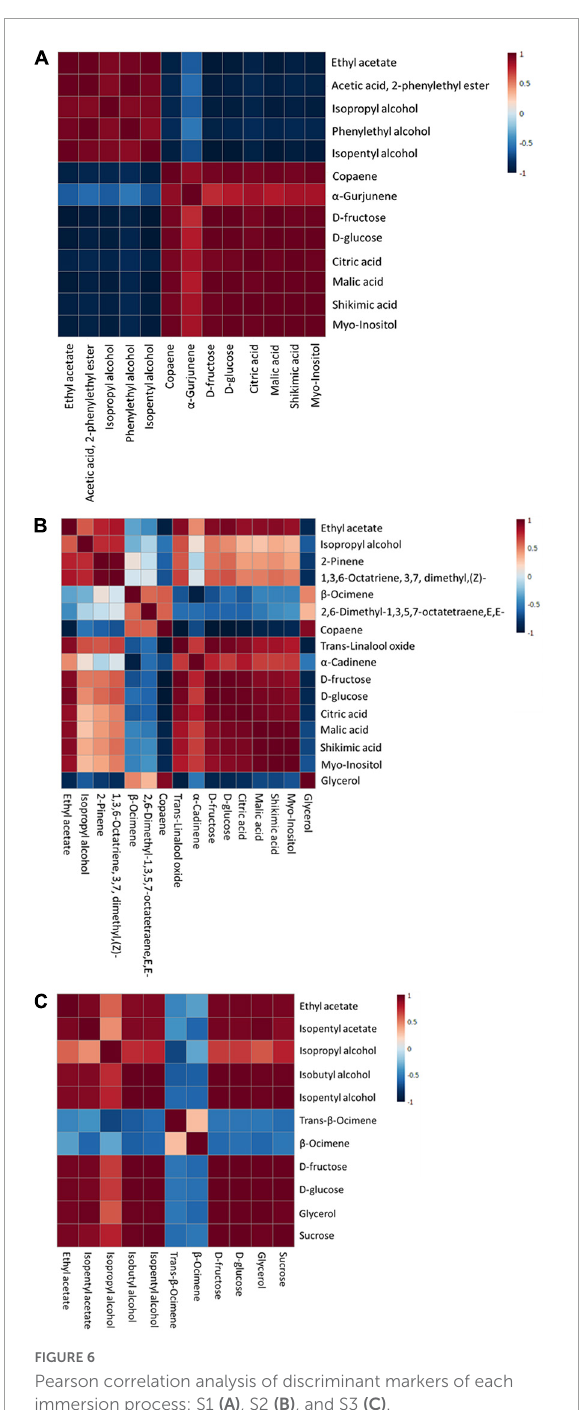
FIGURE6 Pearson correlation analysis of discriminant markers of each immersion process: S1 (A) , S2 (B) , and S3 (C) .